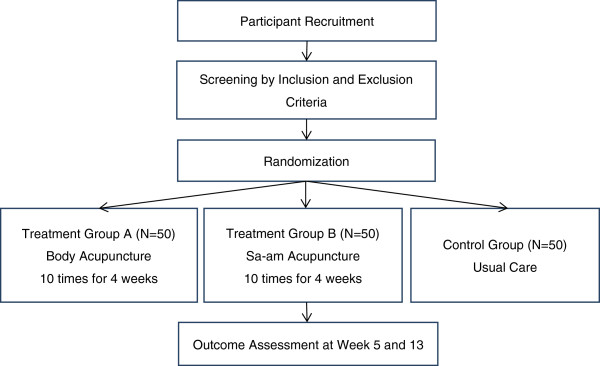
Study flow chart.